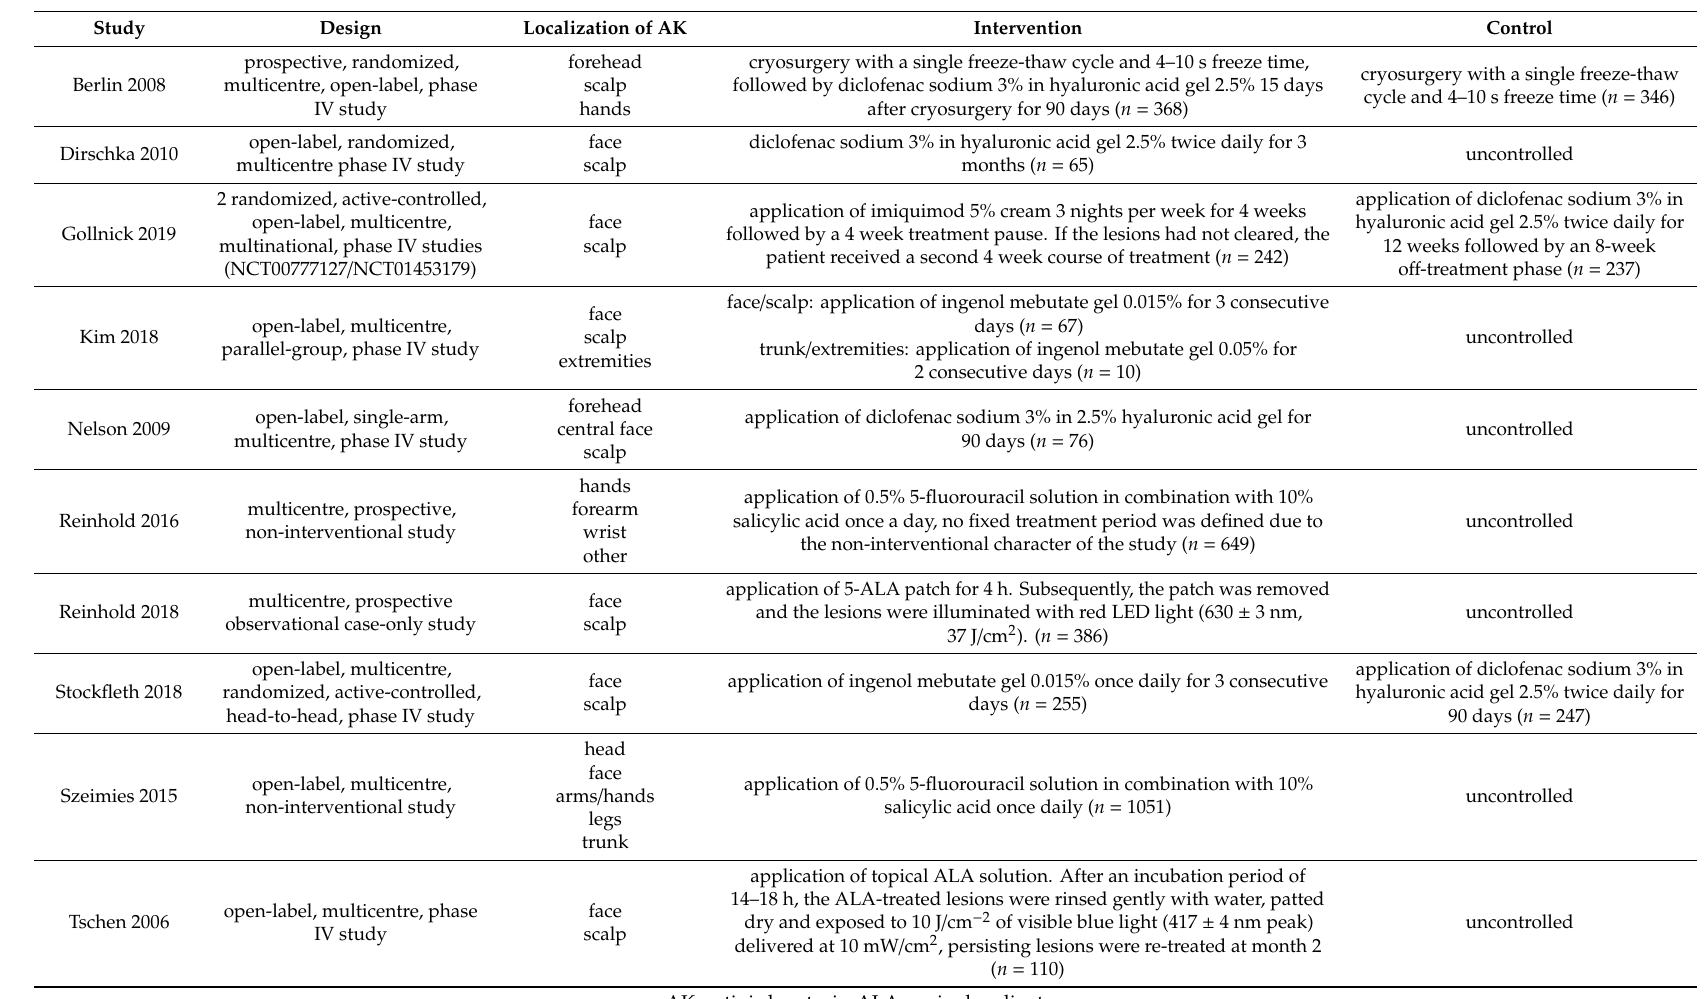
Table 1. Baseline characteristics of the included